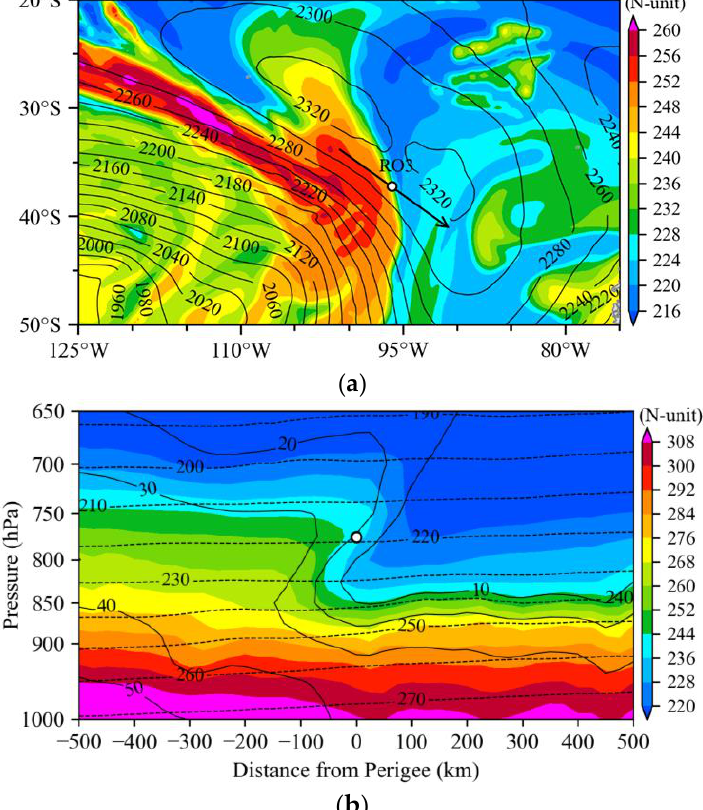
Figure 10. ( a ) Horizontal distribution of refractivity (shaded) and geopotential height (contour, unit: gpm, contours) at 775 hPa, and ( b ) vertical cross-section of total refractivity (shaded), wet refractivity (solid curves) and dry refractivity (dashed curves) along the tangent direction (black arrow) at the perigee point (black open circle) of RO3. The refractivity is calculated from ERA5 reanalysis at